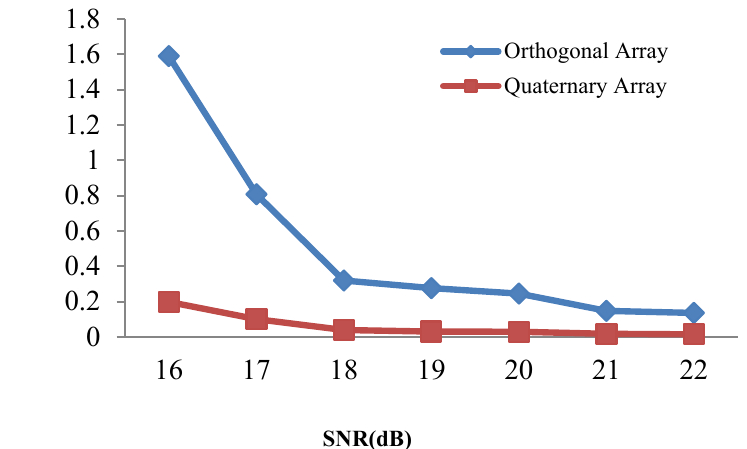
Figure 12. Comparison of the x-axis positioning accuracy of Kalman filtering for different arrays and different SNR values.